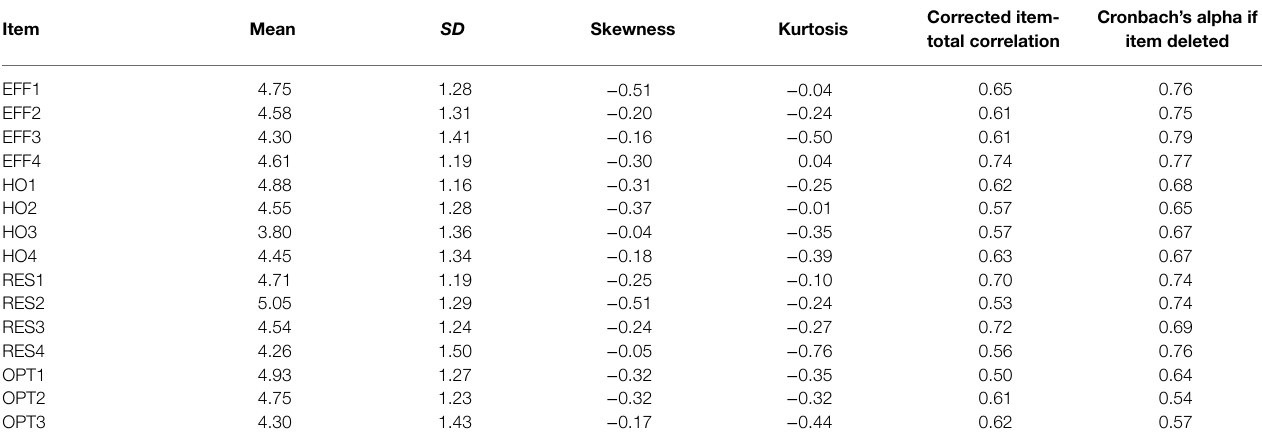
TABLE 1 | Item-level analyses for the school PsyCap scale.